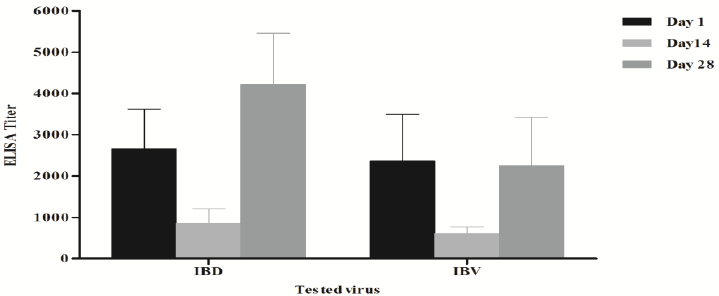
Figure 1. Mean enzyme-linked immunosorbent assay (ELISA) antibody titers against Infectious bronchitis virus (IBV) and Infectious bursal disease (IBD) at 0, 14, and 28 days of age, post-vaccination.